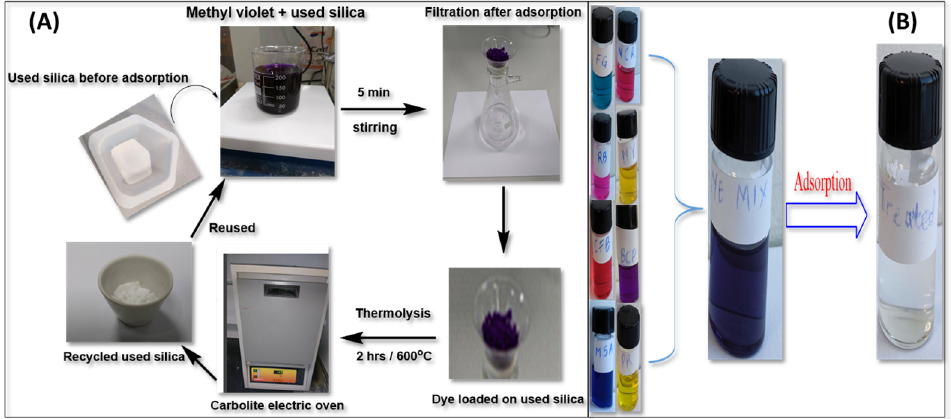
Figure 1. ( A ) Process of the adsorption of methyl violet from an aqueous solution on used silica gel, recycling of the silica gel, and reuse of the sorbent material. ( B ) Selective adsorption of a dye mixture containing 8 dyes (designated as solution A in the text).